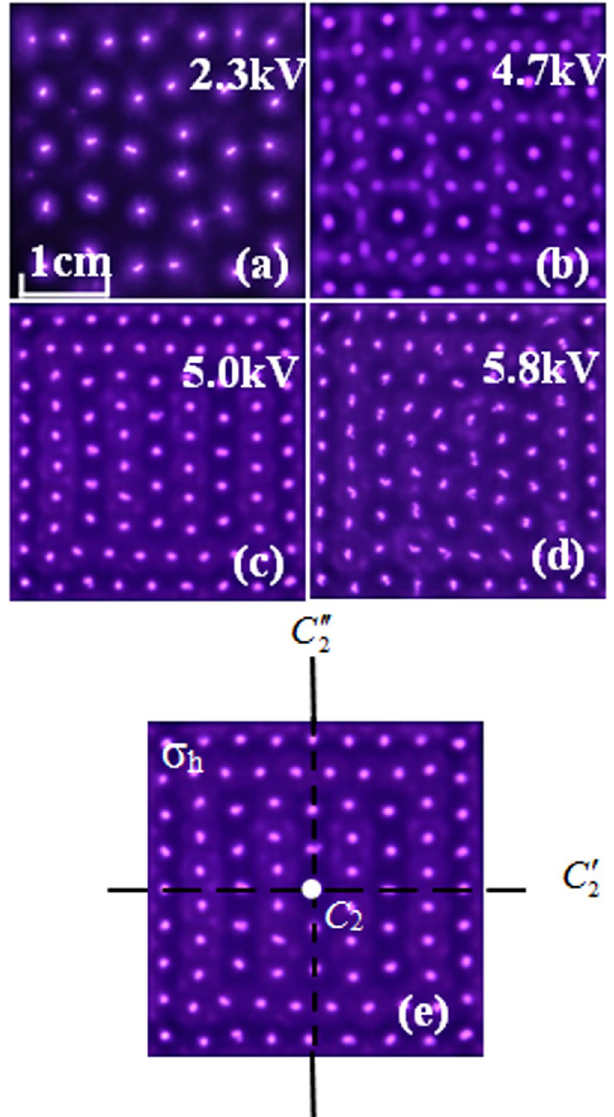
Figure 1. Evolution of patterns with increasing voltage. ( a ) Random filaments, U = 2.3 kV. ( b ) White-eye square grid state, U = 4.7 kV. ( c ) Complex pattern with hexagonal lattice and white-eye stripe, U = 5.0 kV. ( d ) Chaotic state, U = 5.8 kV. ( e ) The symmetric operations of ( c ). Other experimental parameters: gas pressure p = 40 kPa, argon concentration ϕ = 50%, driven frequency f = 60 kHz, gas gap d = 3.0 mm, exposure time of the pictures t = 40